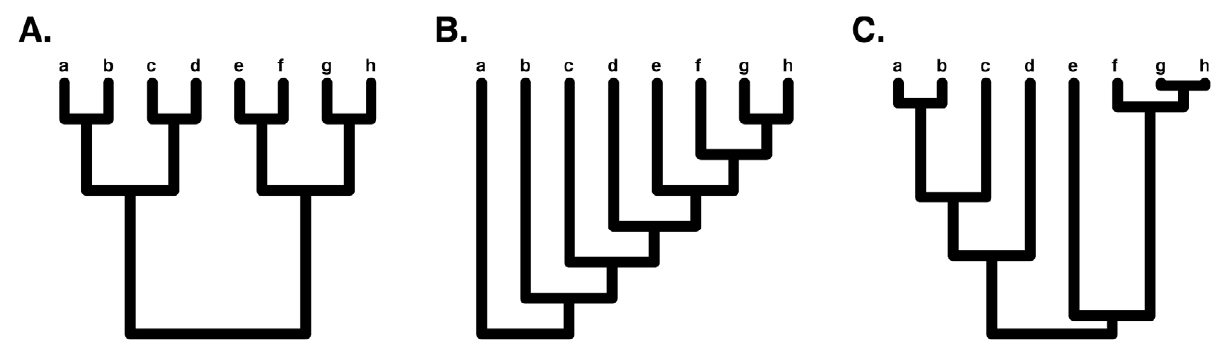
Figure 2. Balanced (A), imbalanced (B), and random birth-death (C) phylogenetic trees of eight species (a–h).